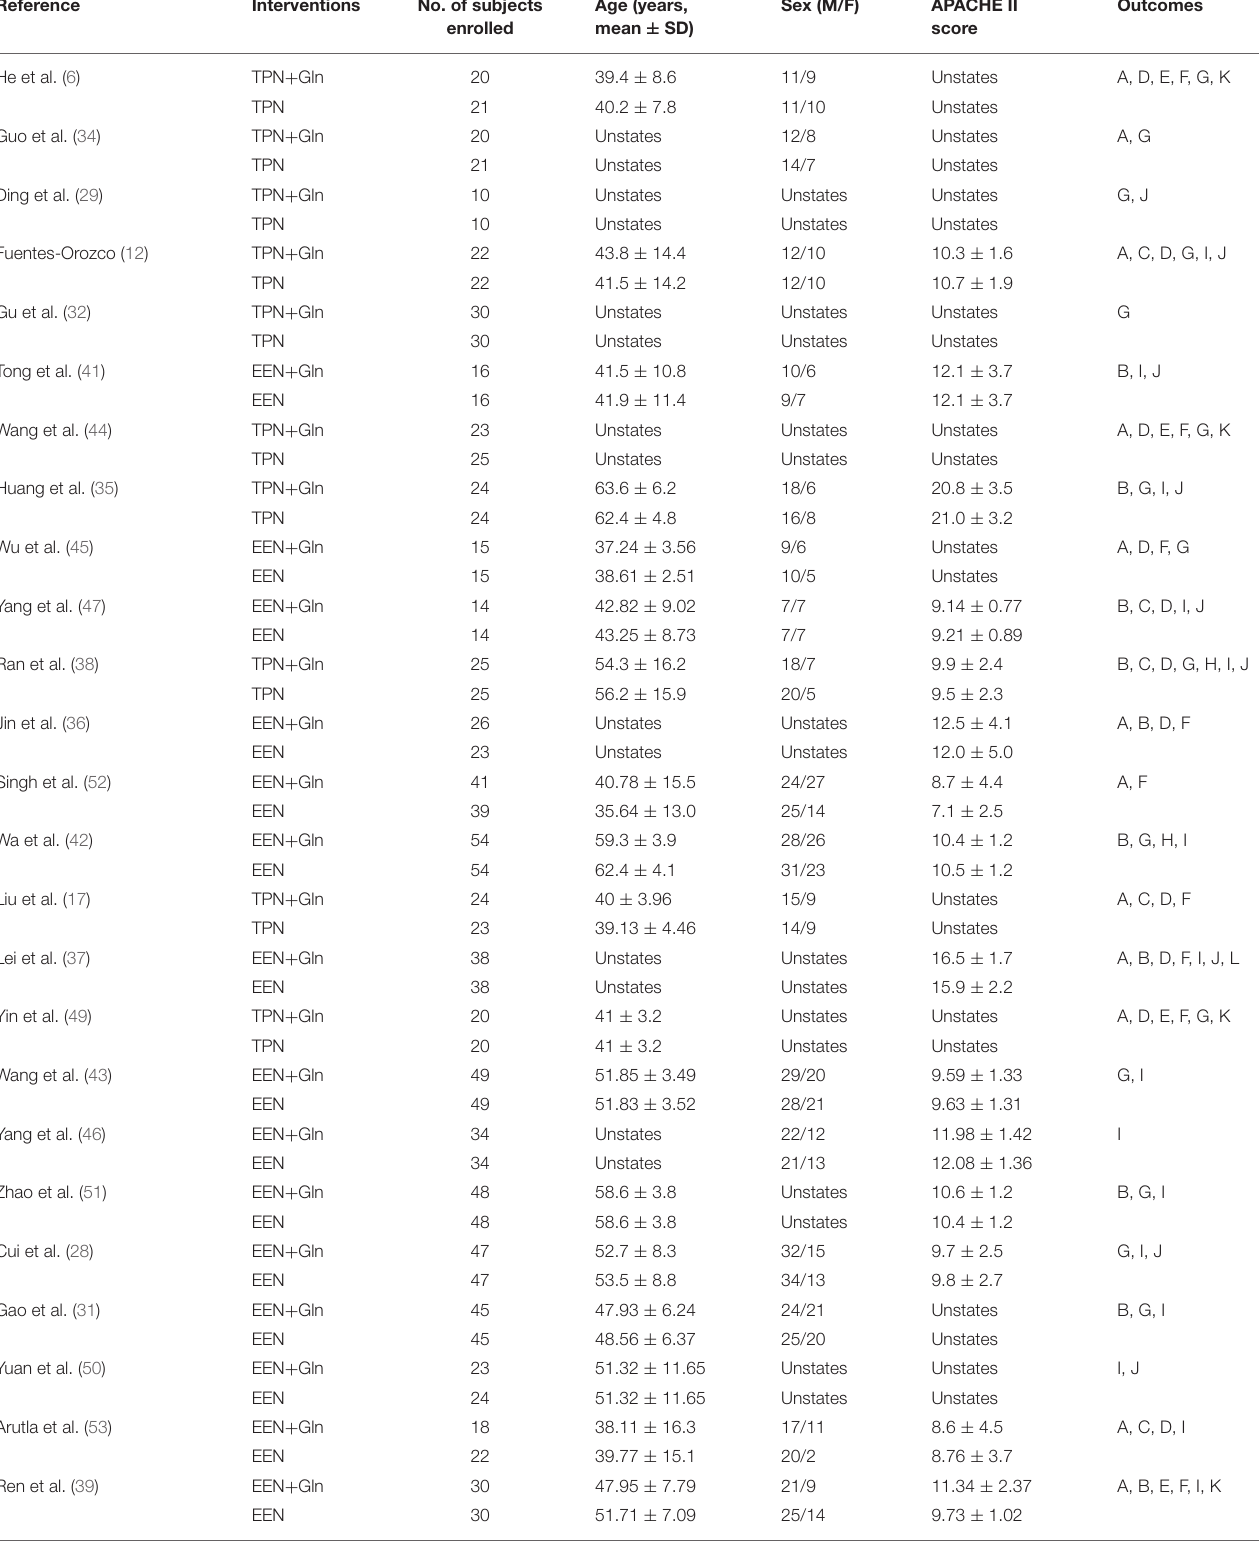
TABLE 2 | Summary of the basic characteristics of the included studies.